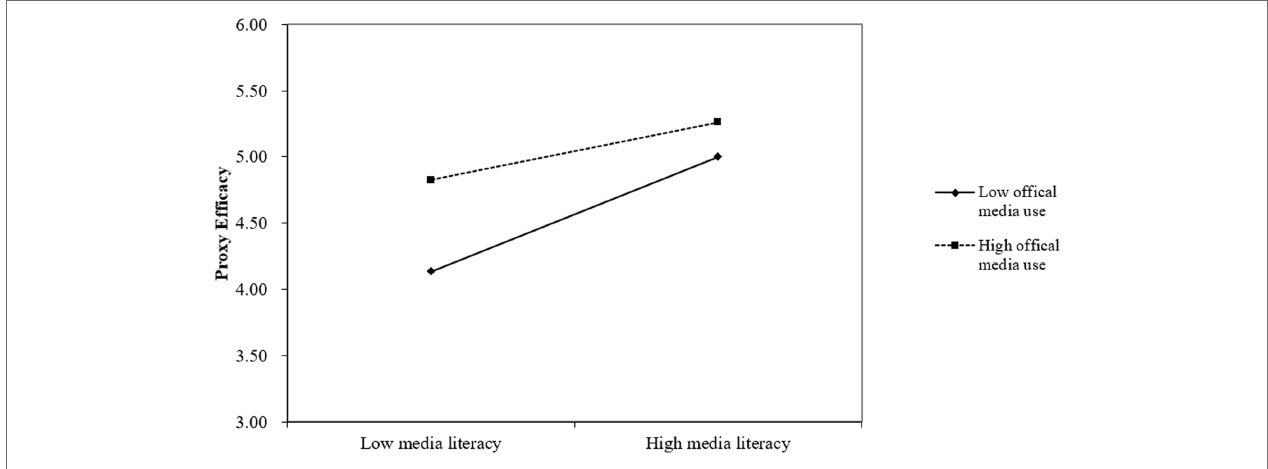
FIGURE 2 | The moderation effect.